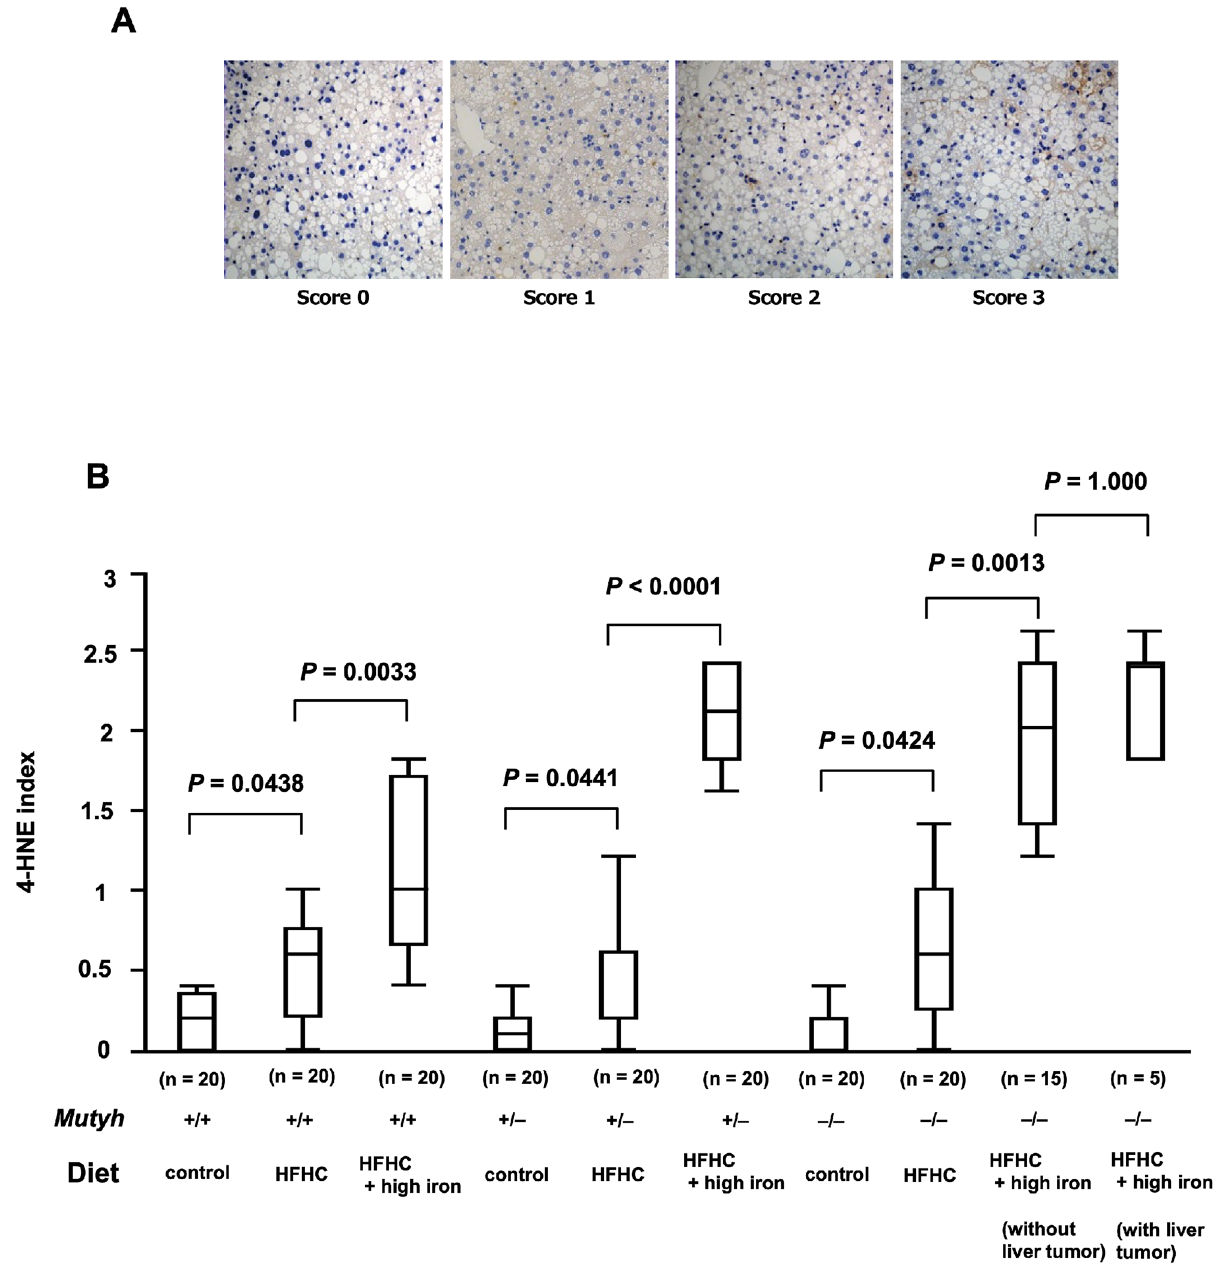
Figure 4. Liver sections stained with 4-HNE stain. ( A ) The intensity of 4-HNE immunostaining was scored from 0 to 3; 0 no staining, 1 mild (punctuated labeling), 2 moderate (dense labeling in a few cells), 3 strong (dense and homogenous labeling in numerous cells). At least five random fields were examined for each sample and the average of the scores was determined as the 4-HNE index. ( B ) The 4-HNE stain index. The index was significantly higher in the HFHC diet groups than the control diet group ( Mutyh +/+ , HFHC diet group vs. Mutyh +/+ , control diet group; P = 0.438, Mutyh +/− , HFHC diet group vs. Mutyh +/− , control diet group; P = 0.0441, Mutyh −/− , HFHC diet group vs. Mutyh −/− , control diet group; P = 0.0424) and significantly higher in the HFHC + high-iron diet groups than the HFHC diet groups ( Mutyh +/+ , HFHC + high-iron diet group vs. Mutyh +/+ , HFHC diet group; P = 0.0033, Mutyh +/− , HFHC + high-iron diet group vs. Mutyh +/− , HFHC diet group; P < 0.0001, Mutyh −/− , HFHC + high-iron diet group vs. Mutyh −/− , HFHC diet group; P = 0.0013). There was no significant difference in the index according to the presence or absence of tumor development ( P = 1.000). Data analysed with a Kruskal–Wallis test followed by Dunn–Bonferroni test. For all data analysis P < 0.05 considered significant. Data are shown as box plots for each group of mice. Median values are shown by the line within the box. The bottom and top edges of the boxes represent the 25th and 75th percentiles, respectively. HFHC, high- fat high-carbohydrate; 4-HNE,